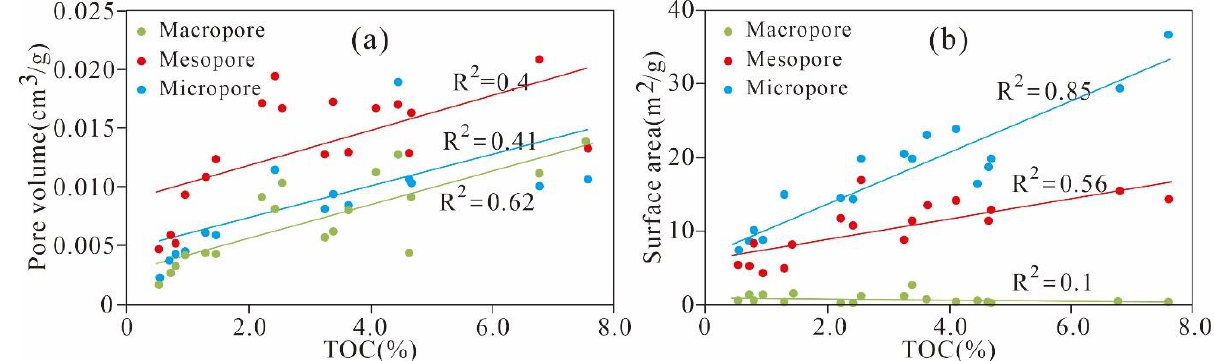
Figure 10. Relationship between the TOC content and pore structure in Ximaling shale (( a ): pore volume; ( b ) surface area).